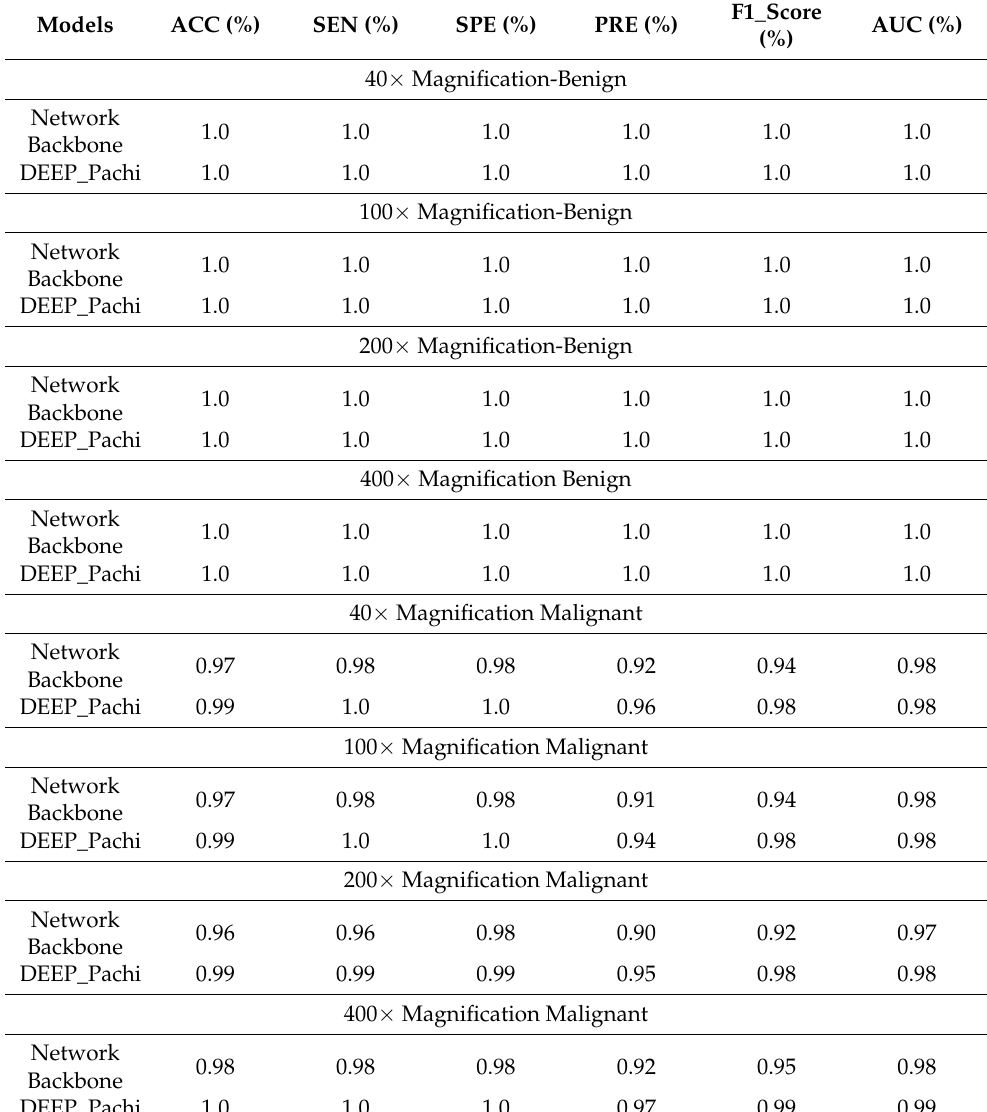
Table 9. Multiclass classification using DEEP_Pachi vs. the network